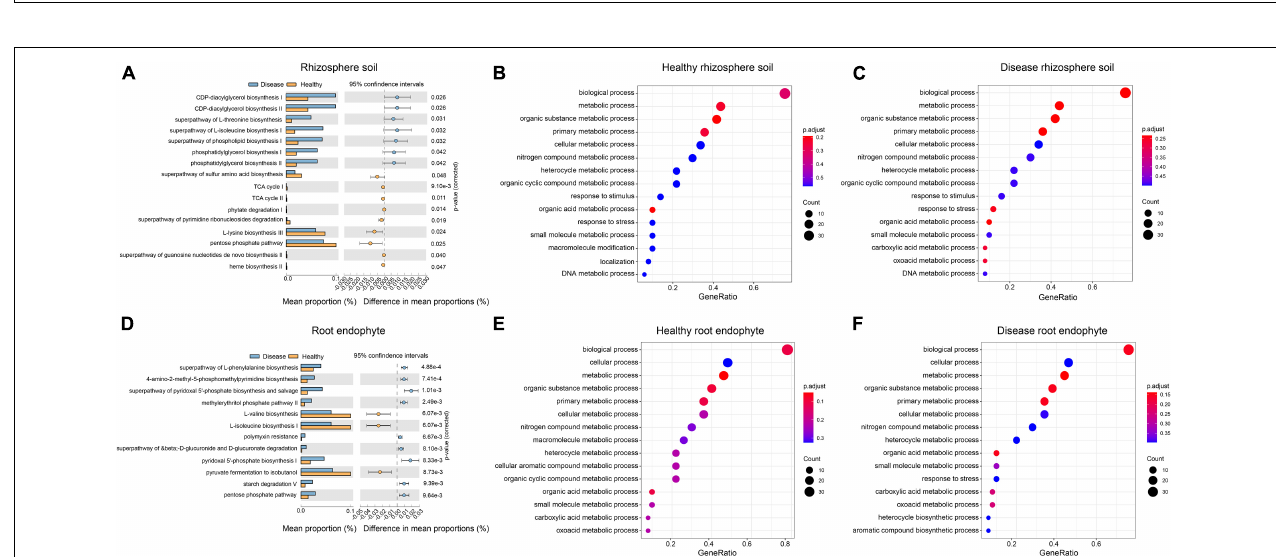
FIGURE 4 | Differences in the functional composition of the rhizosphere soil and root endophyte microbial communities associated with healthy and root rot P. notoginseng . Panels (A,D) show the functional pathways with significant differences between healthy and diseased samples, respectively. Panels (B,C,E,F) represent the Gene Ontology (GO) enrichment annotation results for each